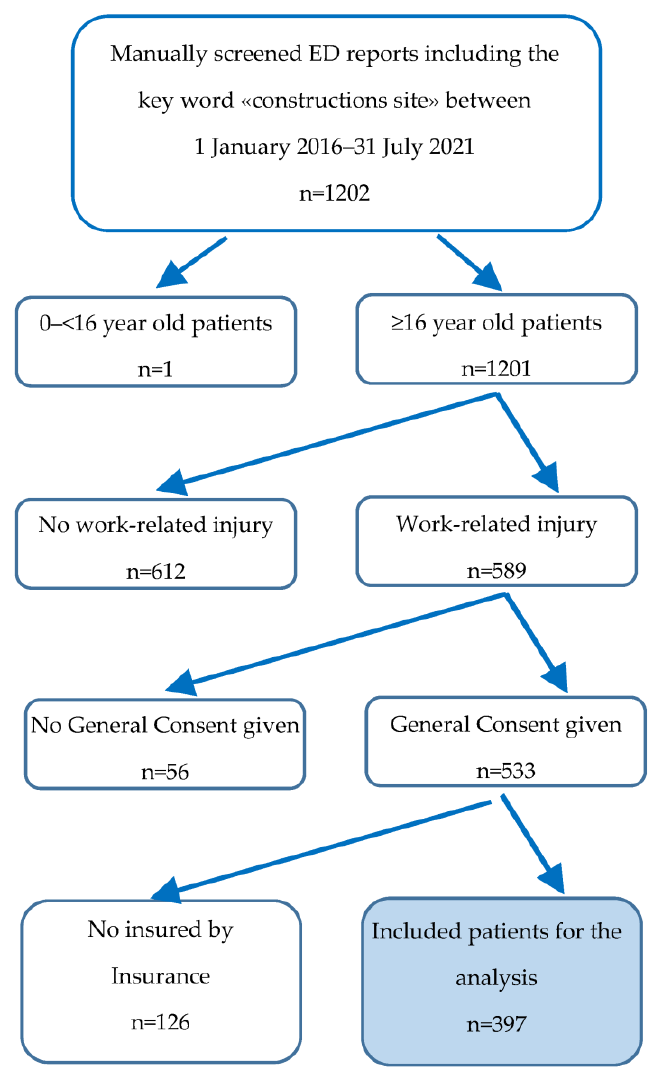
Figure 1. Flow chart of medical record selection.